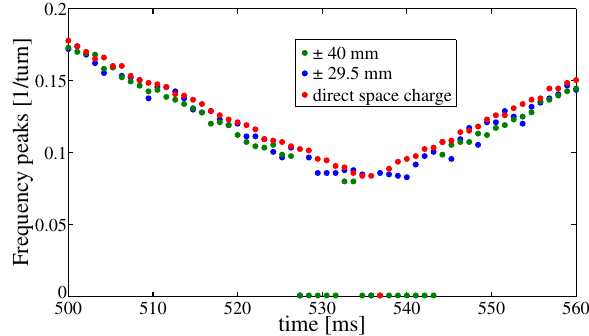
FIG. 26. Vertical coherent tune peaks. The dots are the maxima of the first order vertical momenta of the beam (magenta points of Fig. 25).